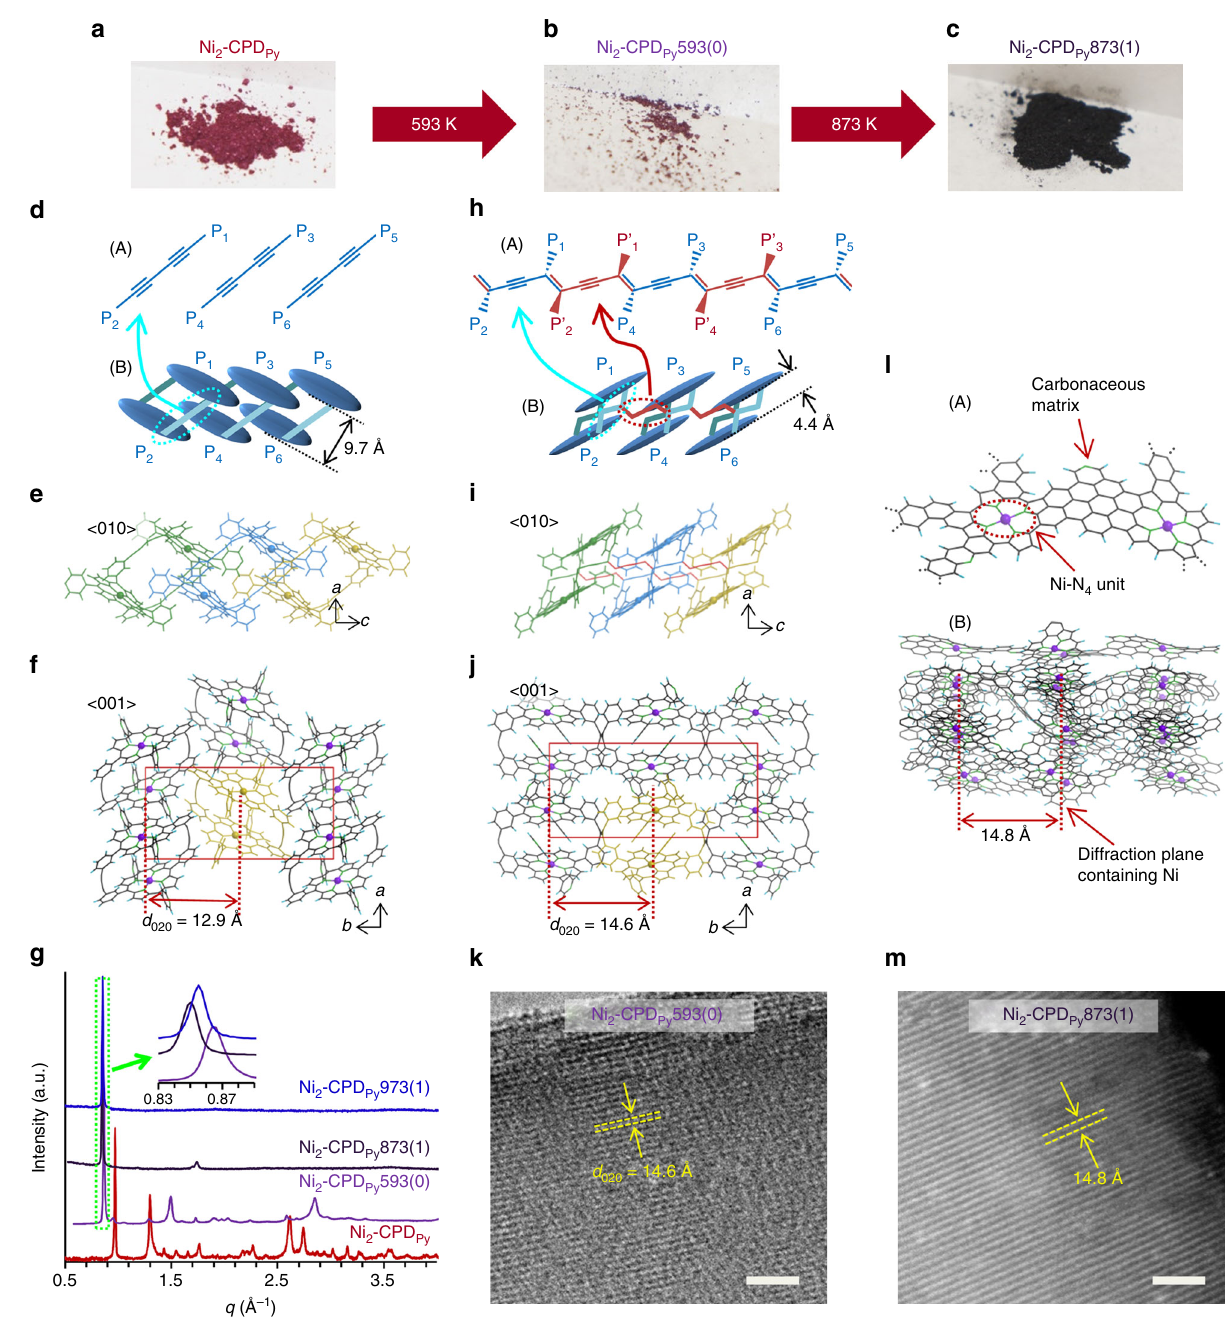
Fig. 2 Structure evolution of Ni 2 -CPD Py upon heat-treatment. a – c Photographs of ( a ) Ni 2 -CPD Py , ( b ) Ni 2 -CPD Py 593(0), and ( c ) Ni 2 -CPD Py 873(1). d Schematic representation of diacetylene chains (A) and Ni 2 -CPD Py molecules (B); P n = porphyrin unit ( n = 1 – 6). e Molecular structure of d -(B): bottom illustration, < 010 > direction; each molecule is displayed in a different colour. f Larger area view: < 001 > direction; yellow part corresponds to the yellow moiety in e . g PXRD patterns of Ni 2 -CPD Py and heat-treated samples; inset: enlarged intense peaks of heat-treated samples. h – j Ni 2 -CPD Py 593(0) packing structure. h Schematic representation of part corresponding to d . In (A), porphyrins locate next to those shown in (B) are indicated with the symbol, P n ’ . i Molecular structure of h -(B): < 010 > direction. Coloured moieties correspond to those in e . j Larger area view from the < 001 > direction; yellow part corresponds to the yellow moiety in i . Red box in f and j is unit cell. k TEM image of Ni 2 -CPD Py 593(0). l Expected molecular-level structure of Ni 2 - CPD Py 873(1); an enlarged part (A) and a larger region (B) corresponding to j . For f , j , and l : C, H, N, O, Ni = black , light blue , green , red , and purple , respectively. m HAADF-STEM image of Ni 2 -CPD Py 873(1). Scale bars in k and m are 10